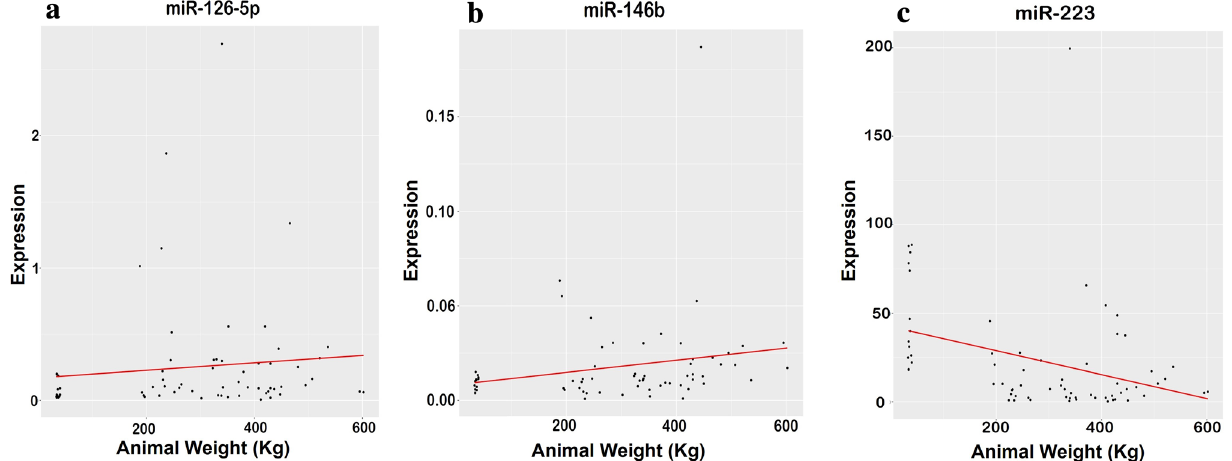
Figure 6. Plot of Spearman correlation results showing the correlation between animal weight (Kg) and miR- 126-5p, miR-146b and miR-223 expression. ( a ) Shows the positive correlation between the expression of miR- 126-5p and animal weight (kg) rho = 0.26 (p = 0.02) ( b ) shows the positive correlation between the expression of miR-146b and animal weight (kg) rho = 0.36 (p = 0.002) ( c ) shows the negative correlation between the expression of miR-146b and animal weight (Kg) rho = − 0.39 (p = 0.001). The solid line indicates the